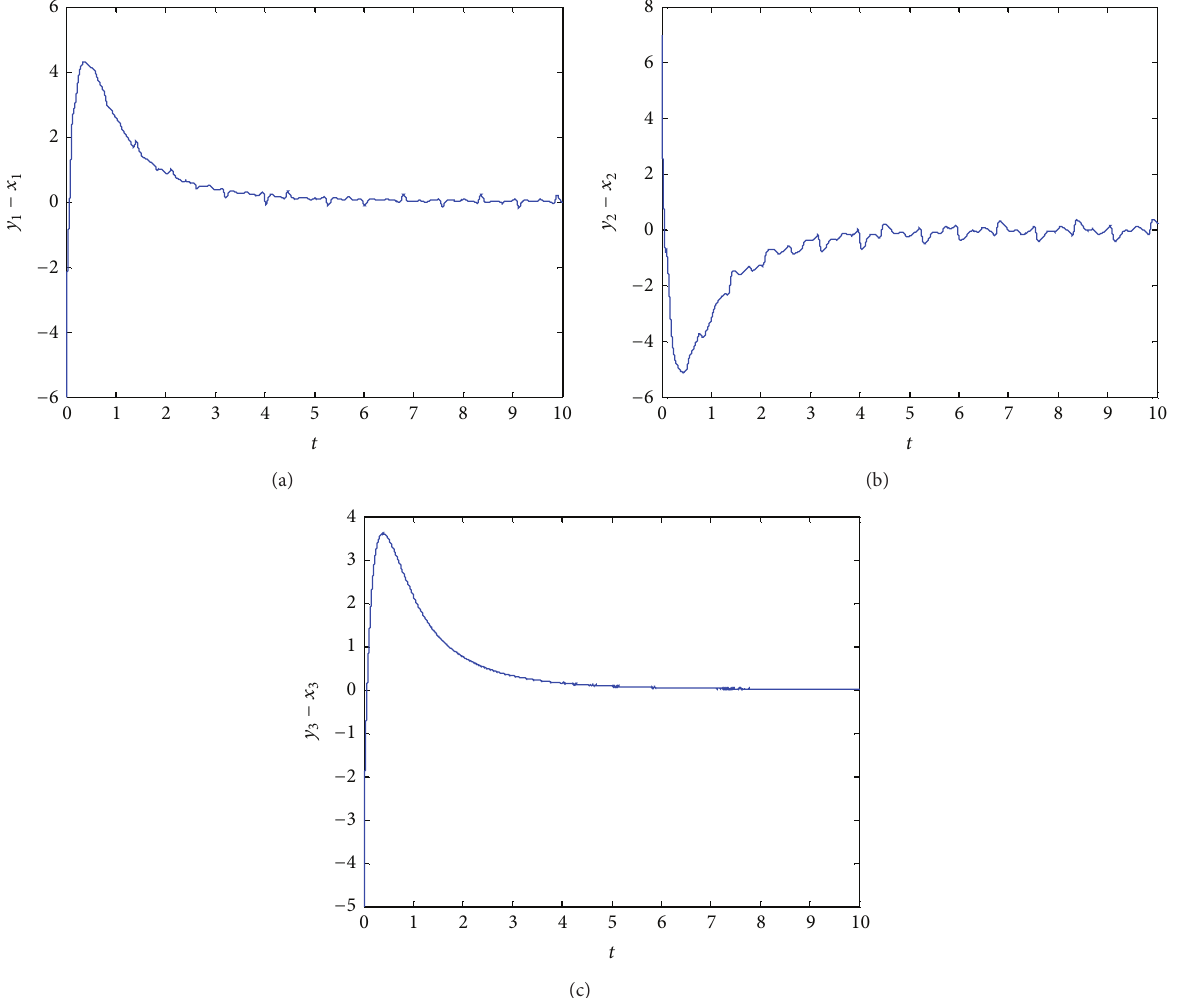
Figure 2: (a) The time evolution of synchronization error 𝑒 1 of the drive system (26) and response system (31). (b) The time evolution of synchronization error 𝑒 2 of the drive system (26) and response system (31). (c) The time evolution of synchronization error 𝑒 3 of the drive system (26) and response system